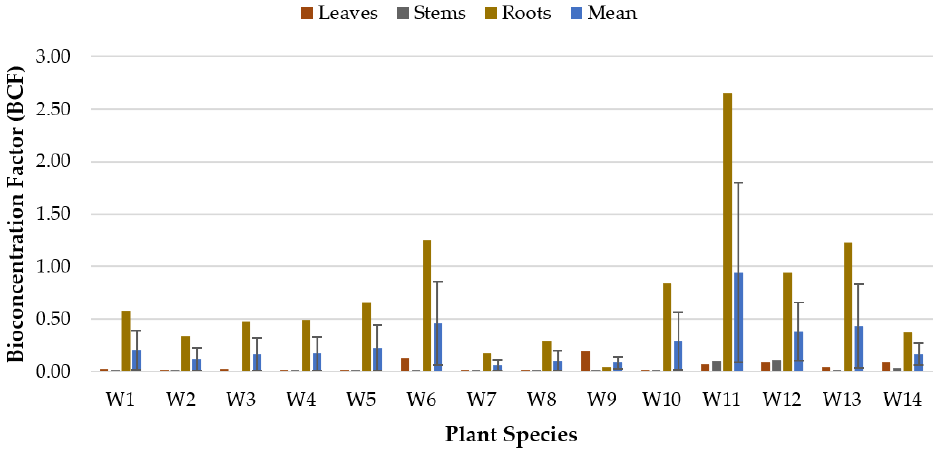
Figure 4. Bioconcentration Factor (BCF) of Iron (Fe) in phytoremediation of domestic sewage mesocosms using various tropical plants.